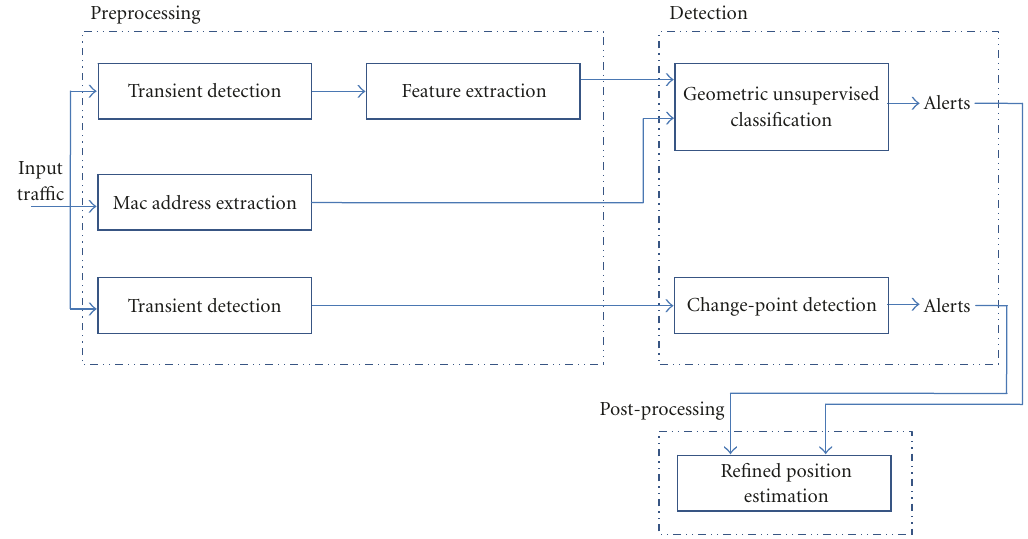
Figure 1: Architecture of the proposed multilayered intrusion detection